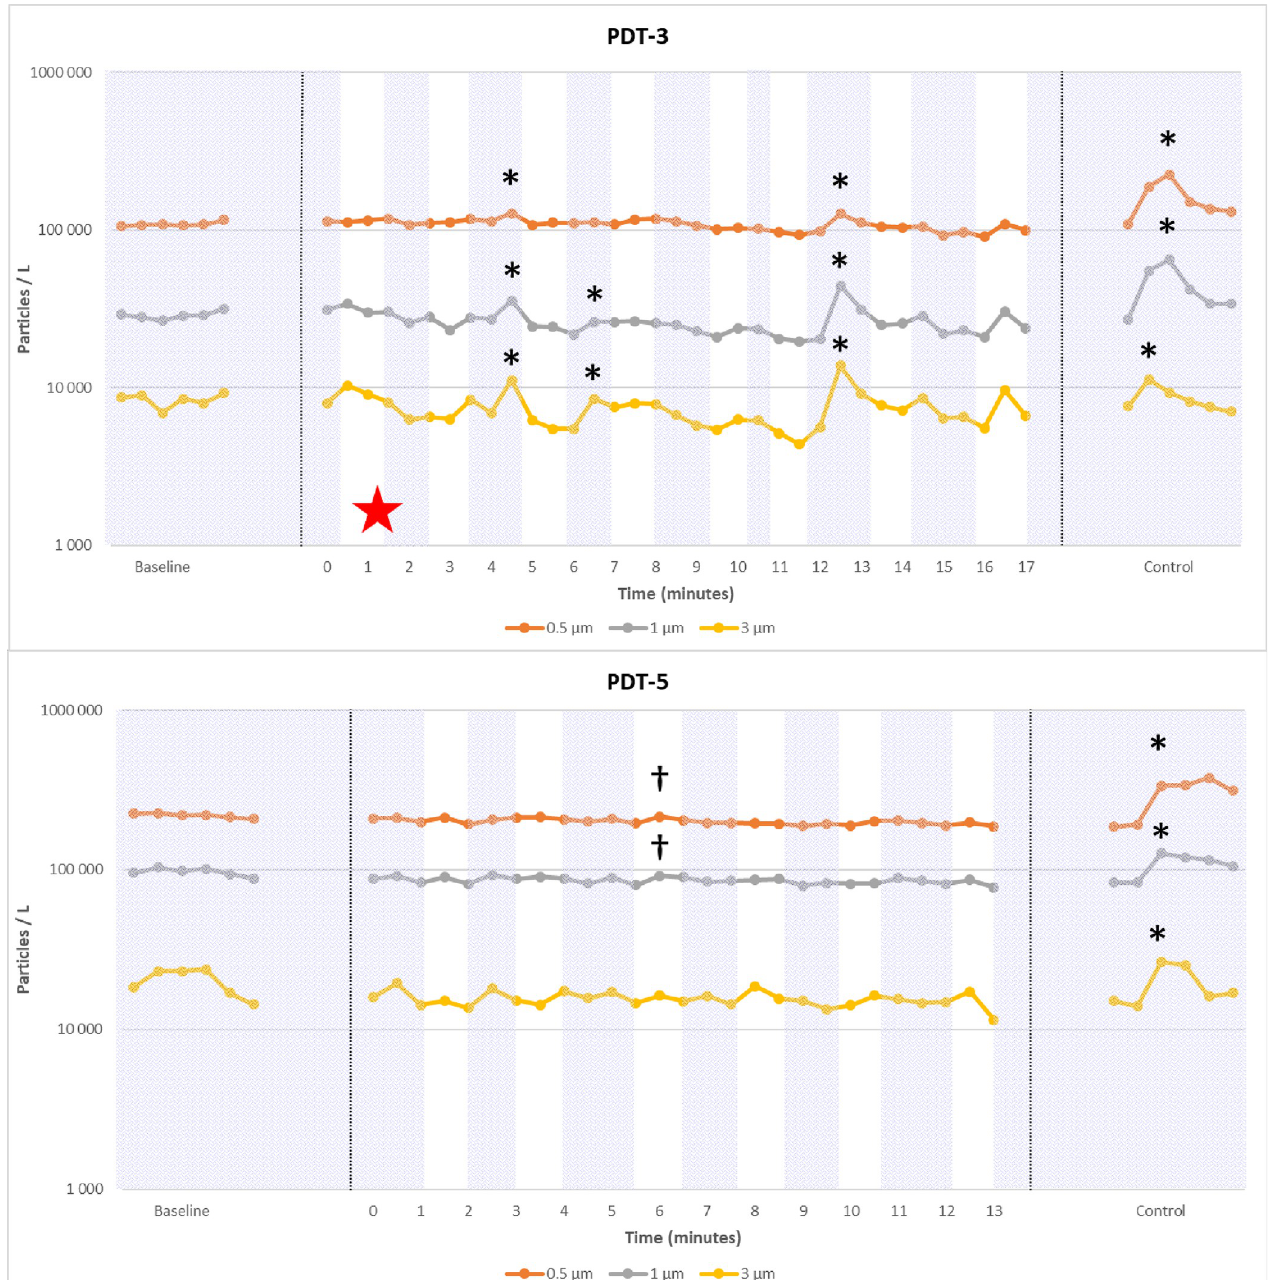
Fig 4. Examples of particle count (logarithmic scale) during two percutaneous dilatational tracheostomy (PDT) procedures. Hatching in the background: Intensive care ventilator on; white in the background: Intensive care ventilator off; � significant peaks related to a breach in ventilation circuit; † significant peaks related to an artifact (like dry gauze use); red star: Uneventful endotracheal tube cuff puncture. Baseline, procedure and intentional aerosol-generating maneuver (control) are shown. During PDT-3, an early cuff puncture was responsible of multiple leaks during the procedure, while no leaks occurred in PDT- 5.